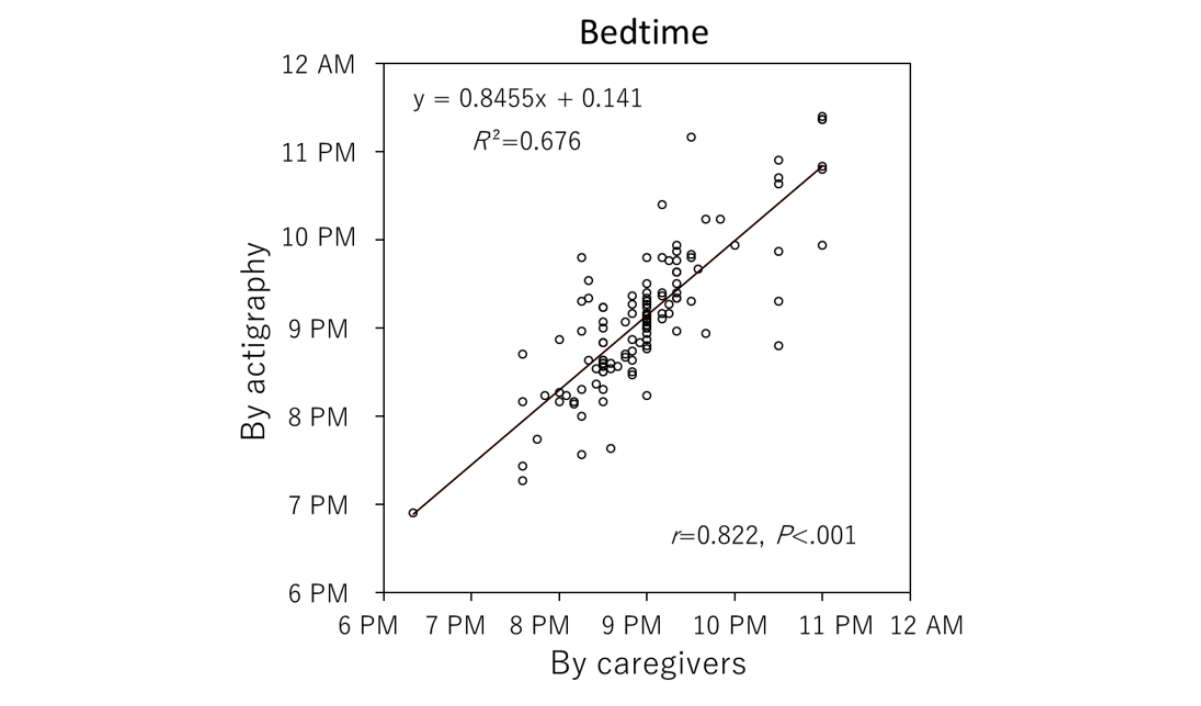
Figure 4. Scatter diagram for the entered data and actigraphy data for bedtimes.